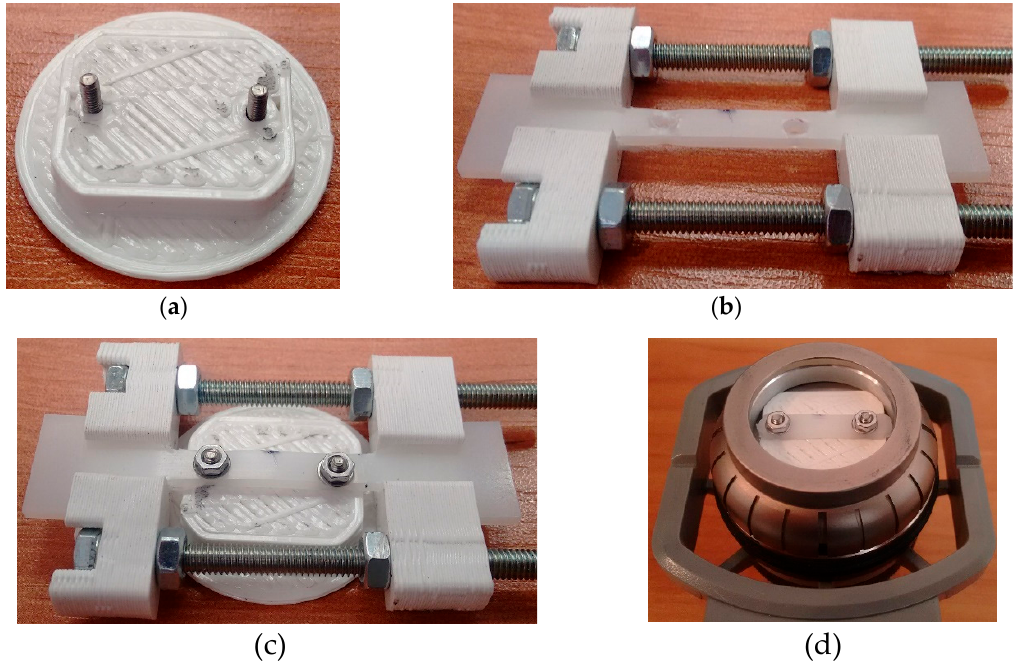
Figure 8. ( a ) Grip adjusted to SEM slot; ( b ) sample with holes made after applying tension; ( c ) stretched sample attached to the grip; and ( d ) deformed polymer placed in the microscope slot.